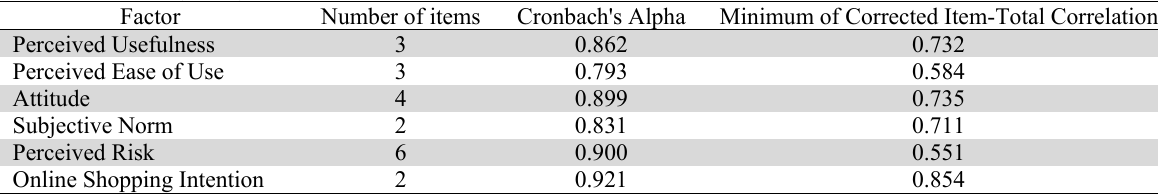
Results of reliability